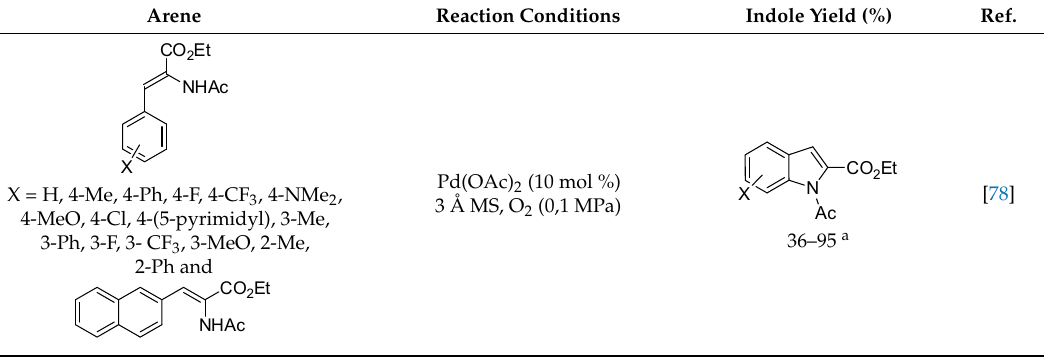
Table 3. Palladium catalyzed oxidative cyclization of substituted arenes to indoles. Arene Reaction Conditions Indole Yield (%) Ref.